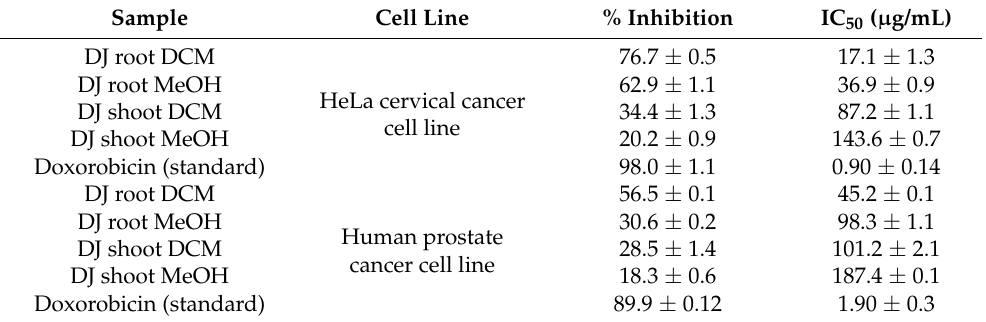
Table 5. Cytotoxic activity of various D. juxtapostia crude extracts at 30 µ g/mL determined by MTT assay.